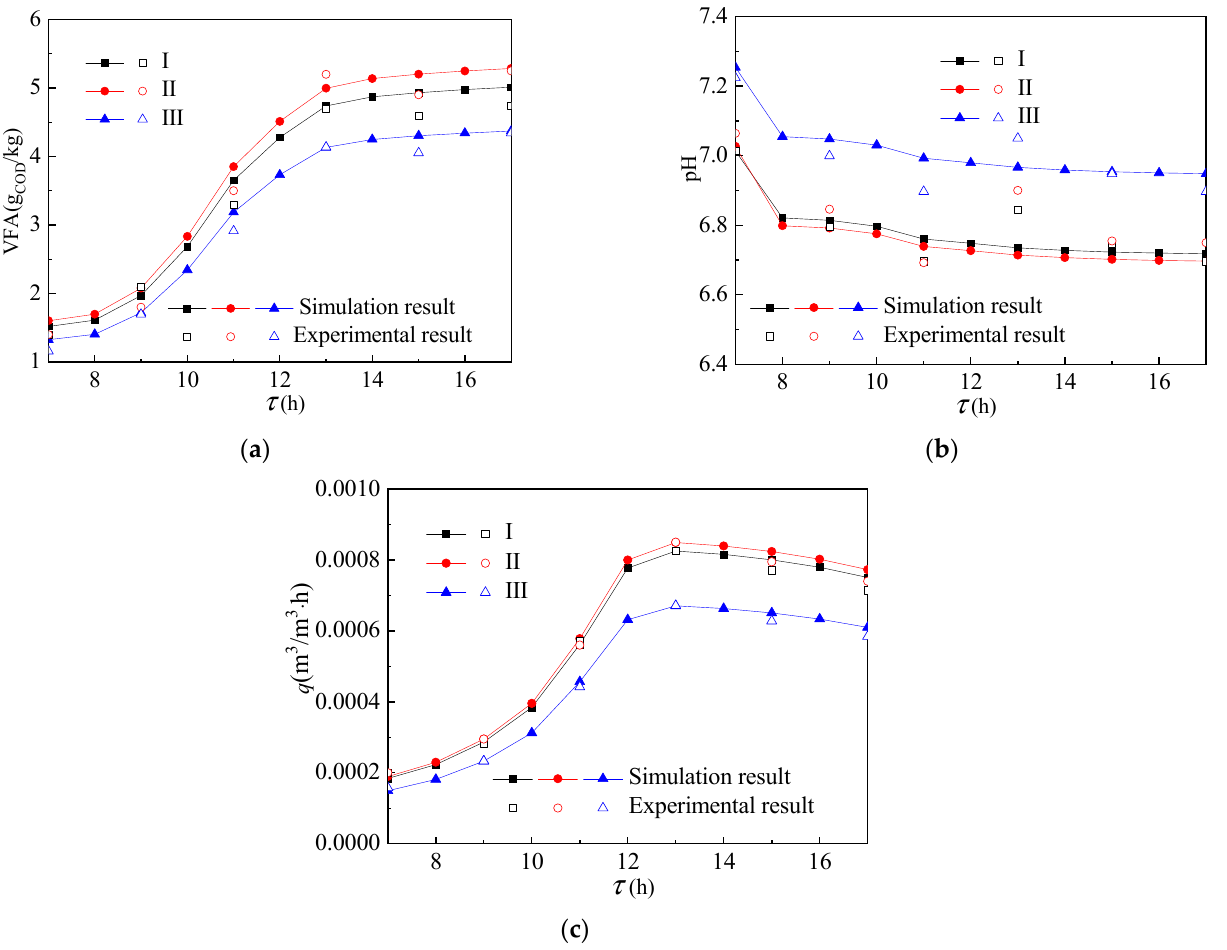
Figure 6. Change of ( a ) VFA, ( b ) pH, and ( c ) gas production of reactants over